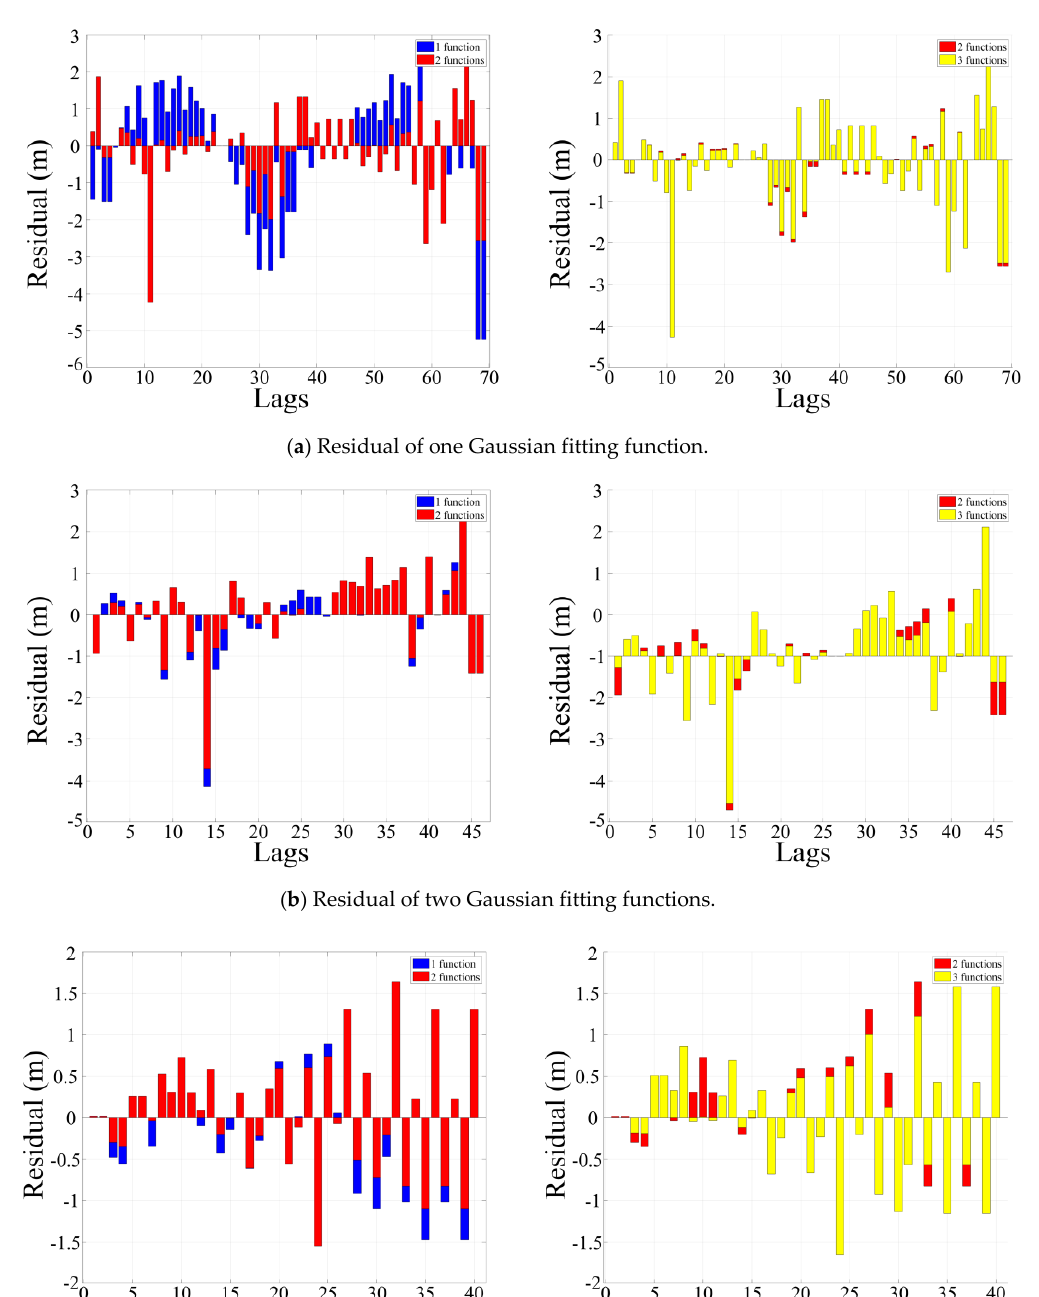
Figure 6. Gaussian fitting of three selected profiles, with the number of functions increasing from one to three. The figures show the upper canopy points as a blue asterisk, the combined model as a red line, and the model components using the single function as green imaginary lines. The magenta imaginary lines are the 99% confidence interval of the Gaussian fitting model.